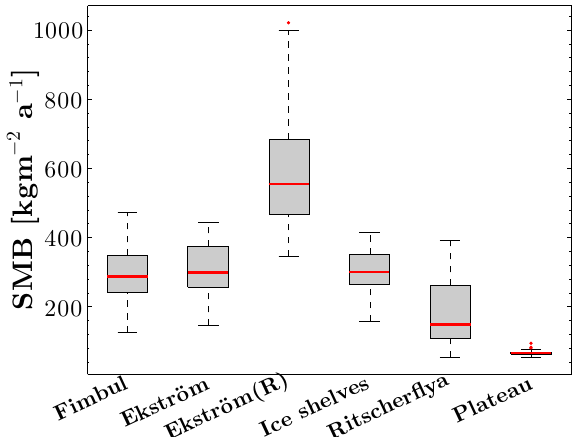
Figure 5. Box plot for the SMB of the stacked records. The red line indicates the median. The tops and bottoms of each box are the 25th and 75th percentiles; the distances between the tops and bottoms are the interquartile ranges. Whiskers are drawn from the ends of the interquartile ranges to the furthest observations within the whisker length, the latter corresponding to 1.5 times the interquartile range. Values beyond the whisker length are marked as outliers and plotted as red